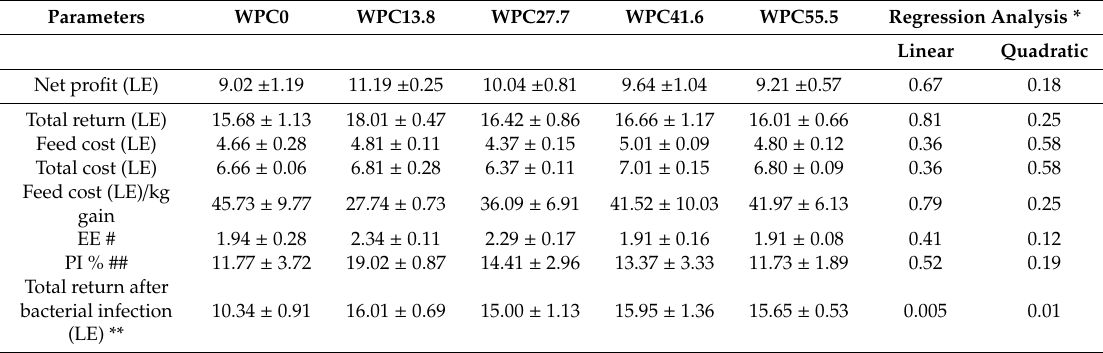
Table 6. The e ff ect of partial replacement of fish meal with whey protein concentrates on the economic e ffi ciency of the experimental diets of Oreochromis niloticus at the end of the experiment. Parameters WPC0